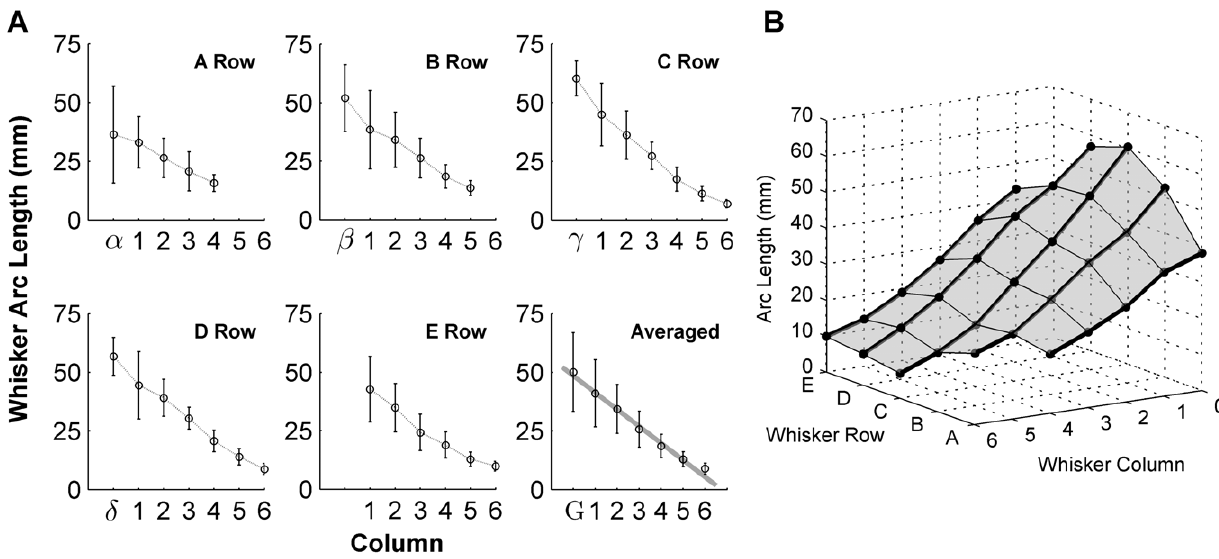
Figure 5. Whisker length dependence on position in the array. ( A ) Each panel shows whisker length as a function of column position within a single whisker row. Error bars are standard deviations of the mean in all panels (G=Greek). The solid gray line in the bottom right panel shows the best linear fit to the averaged data (correlation coefficient r = 2 0.74). ( B ) Thick black lines show the whisker length trend within a row (across columns) and the thin black lines show the trends within a column. Grey panels are visual aids only.